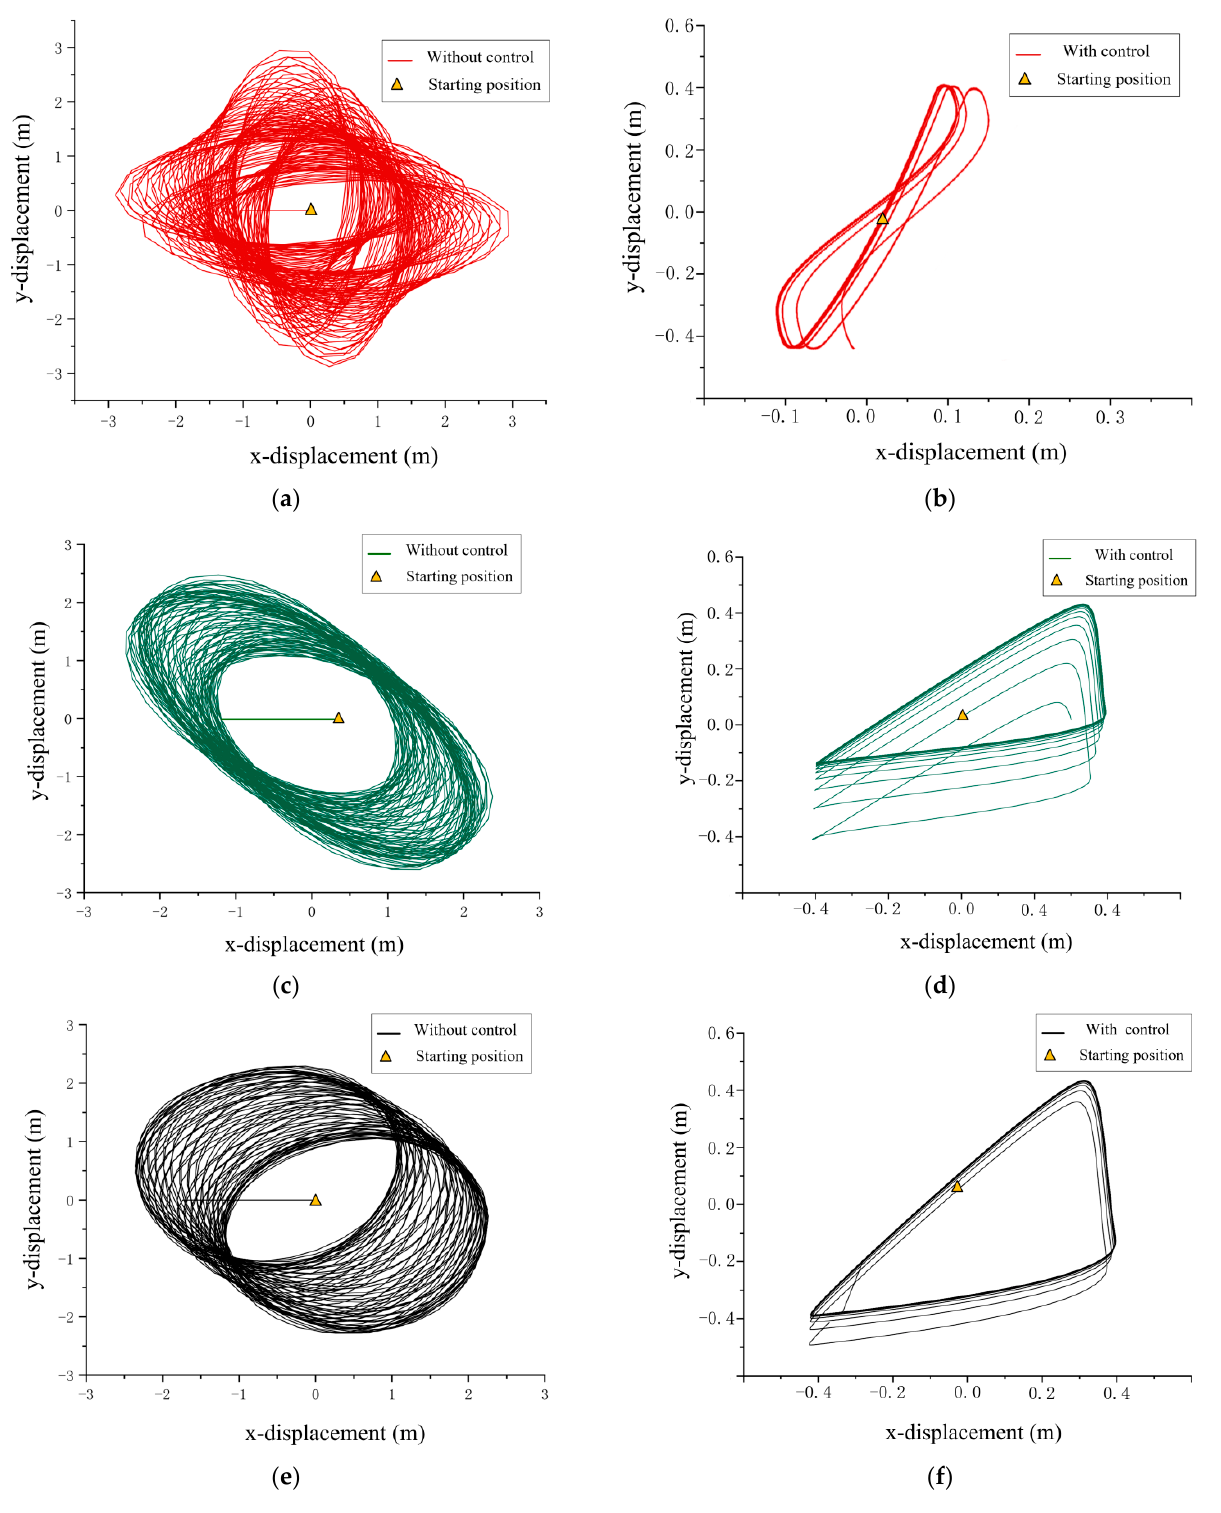
Figure 12. The dynamic response of TTAS under Condition 2. ( a ) the x, y displacement without control of the payload when the hoist cable is 0.6 m; ( b ) the x, y displacement with control of the payload when the hoist cable is 0.6 m; ( c ) the x, y displacement without control of the payload when the hoist cable is 1.2 m; ( d ) the x, y displacement with control of the payload when the hoist cable is 1.2 m; ( e ) the x, y displacement without control of the payload when the hoist cable is 1.8 m; ( f ) the x, y displacement with control of the payload when the hoist cable is 1.8 m.